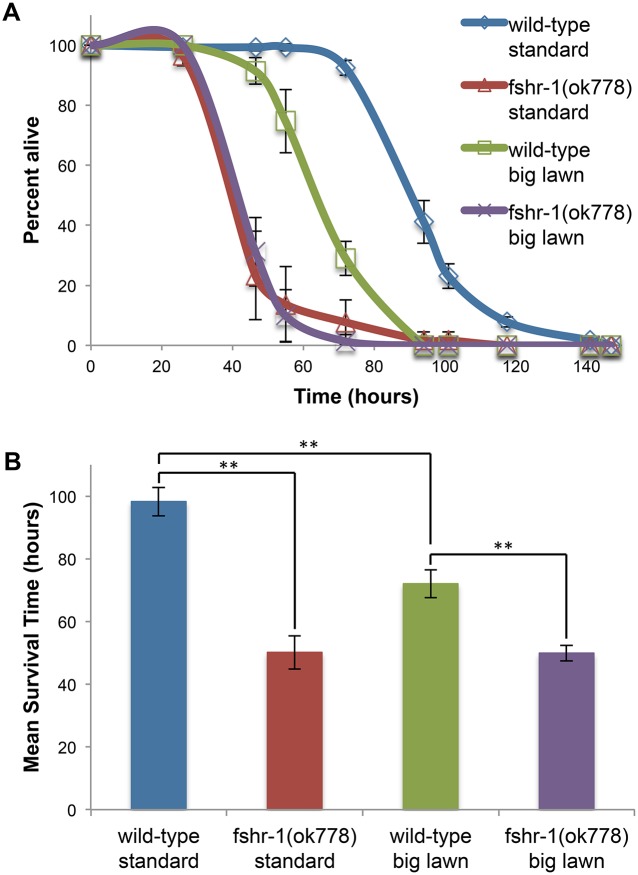
Pathogen avoidance contributes to the pathogen sensitivity of fshr-1 mutants.The survival of worms was measured when exposed to a standard small lawn of PA14 or a big lawn that covered the entire surface of the agar. (A) Representative killing assay. (B) Mean survival time was measured and compared using one-way ANOVA and Tukey HSD test, **P<0.01. Error bars are standard deviation (A) or SEM (B).